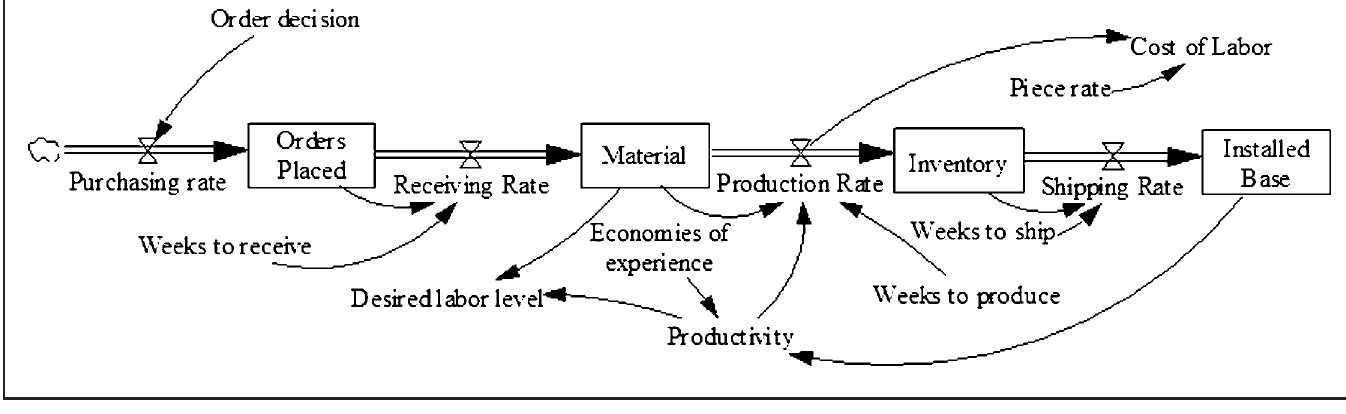
Figure 7. Inventory Sector